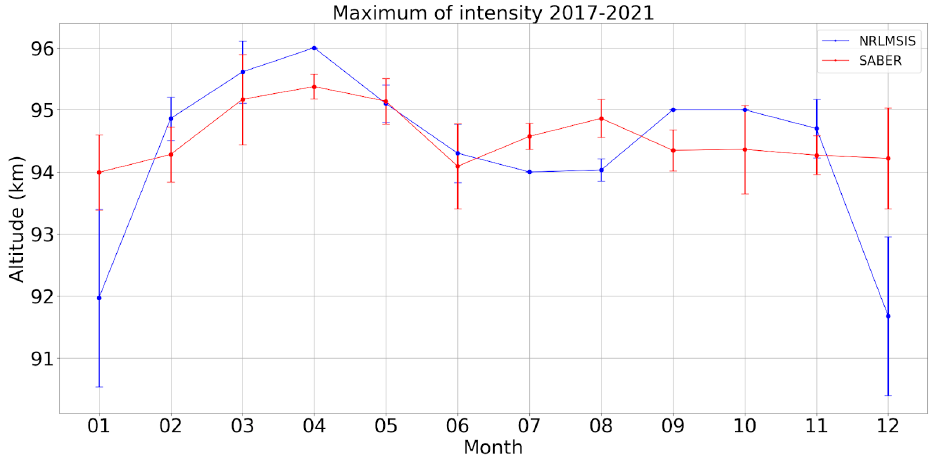
Figure 8. Monthly average altitude of maximum I 557.7 nm and deviations from 2017 to 2021 from SABER (red) and NRLMSIS model (blue) data.